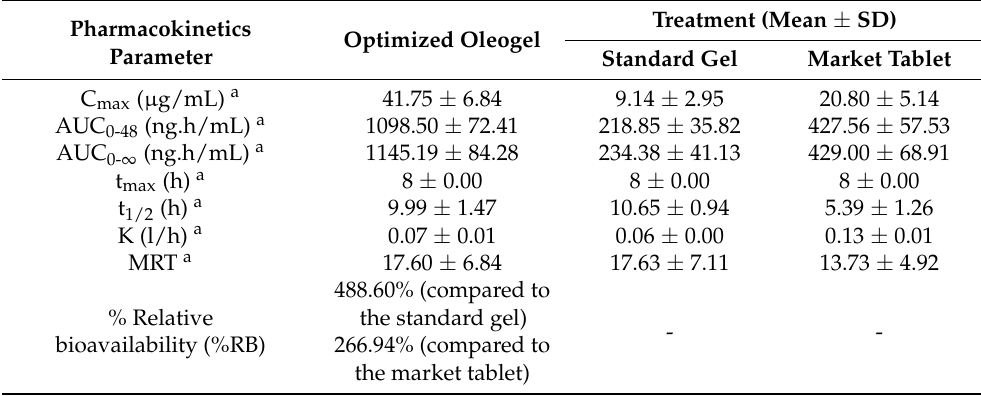
Table 4. Drug pharmacokinetic parameters of OLM after the transdermal application of the optimized oleogel formulation (0.36 mg/0.25 mL), standard gel (0.36 mg/0.25 mL), and oral administration of the market tablet (1.8 mg/kg equivalent to 0.36 mg/0.25